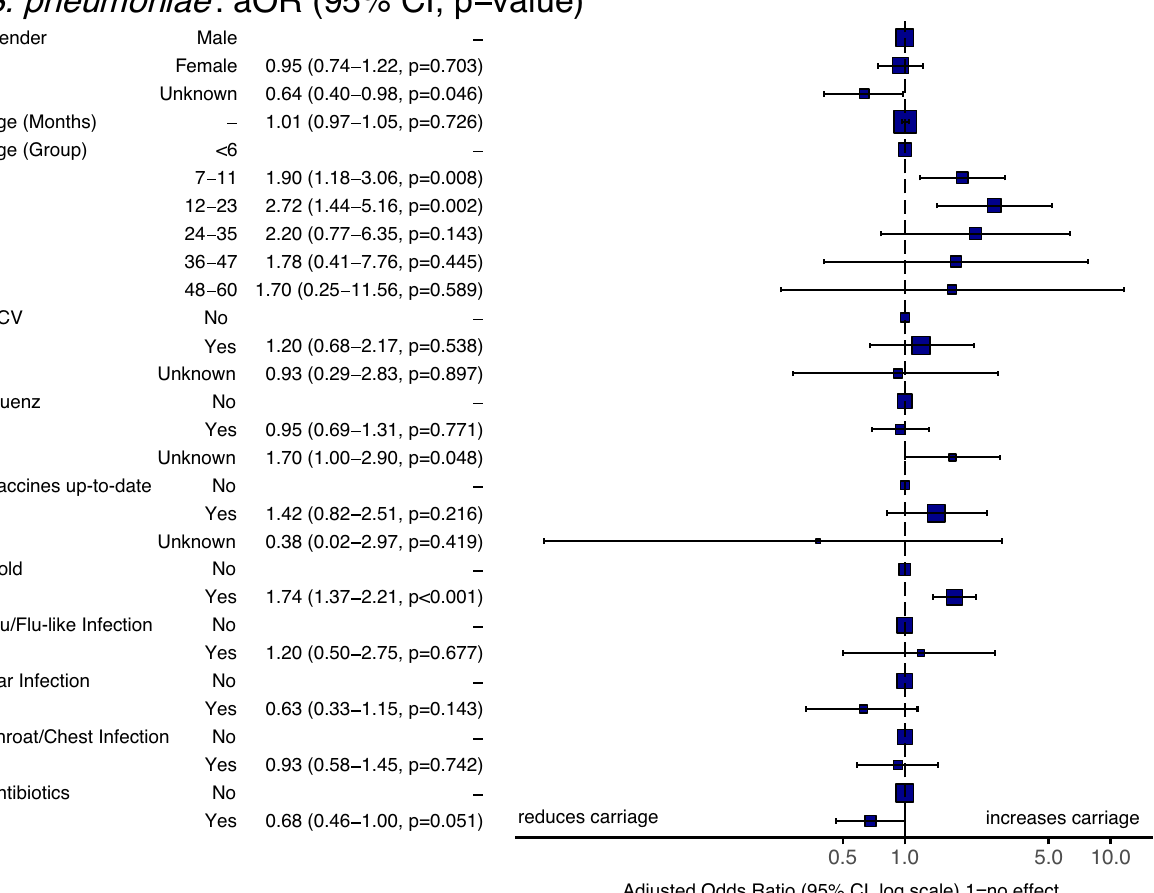
Figure 9. Forest plot showing variables associated with pneumococcal carriage. Odds were calculated using a multivariable logistic regression model. Participants reporting a cold in the previous 30 days were significantly more likely to carry S. pneumoniae (OR 1.73:1.36–2.21, p < 0.001). Age groups 7–11 and 12–23 months were also more likely to be pneumococcal carriers relative to those < 6 months of